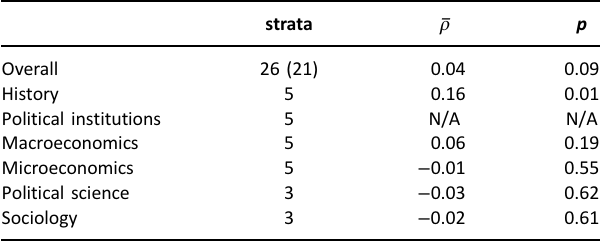
Table 2. Average correlation between SET and final exam score, by subject.